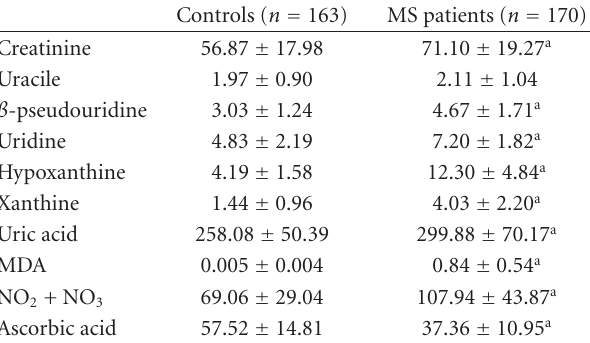
Table 1: Clinical features of MS patients and controls. Table 2: Concentration of circulating creatinine, pyrimidine ( β - pseudouridine and uridine), oxypurines (hypoxanthine, xanthine Controls and uric acid) malondialdehyde (MDA), nitrite and nitrate (NO 2 + NO 3 ), and ascorbic acid determined by HPLC in serum samples of healthy controls and MS